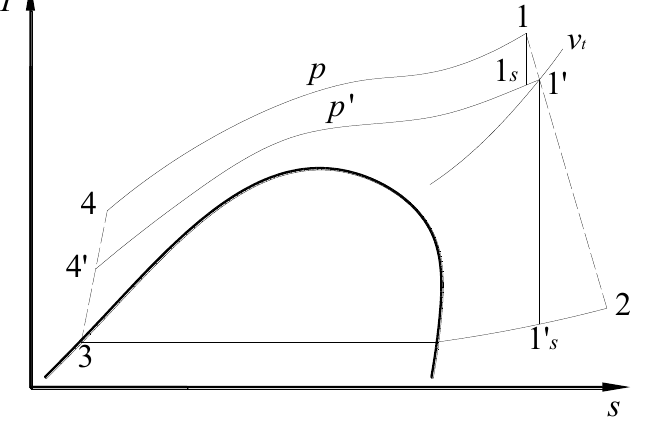
Figure 4. The super-critical ORC with expansion process of Category